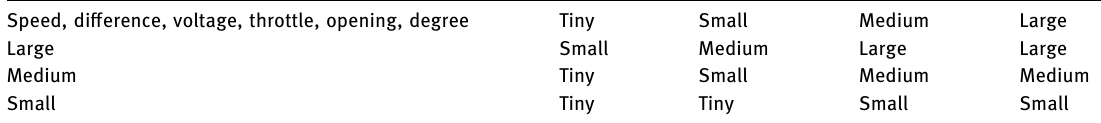
Table 1: DC armature voltage fuzzy control rules Speed, di ff erence, voltage, throttle, opening,